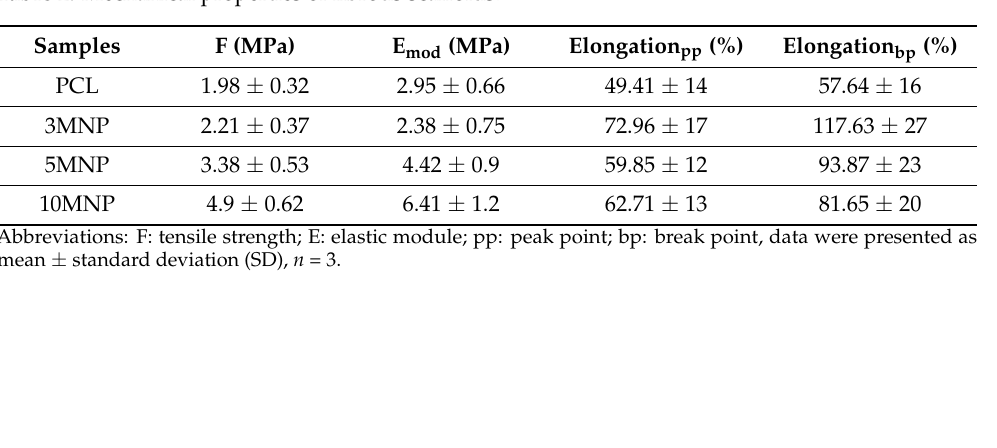
Figure 8. Contact angles of the fibrous scaffolds, ( a ): PCL, ( b ): 3MNP, ( c ): 5MNP, and ( d ): 10MNP, data were presented as mean ± standard deviation (SD), n = 5.